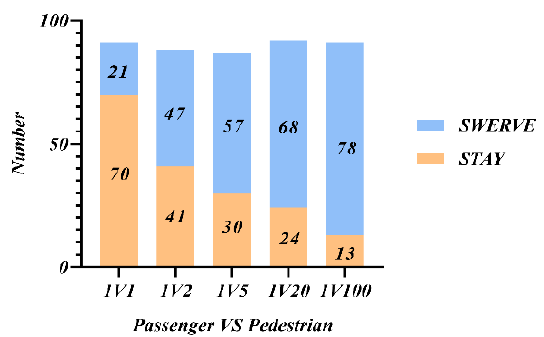
Figure 2. Participants’ preferred choice.